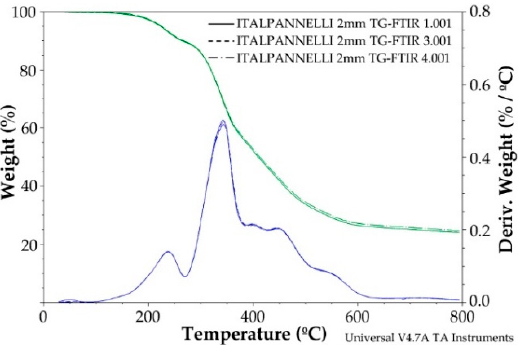
Figure 3. ( a ) TGA of the polyurethanes (P) and ( b ) polyurethanes (B) that come from the insulation industry for refrigeration from the Paneles Aislantes Peninsulares (PAP) Factory.